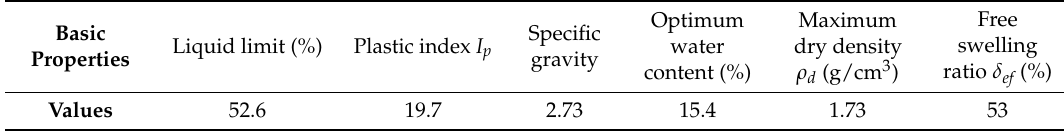
Table 1. The basic properties of the